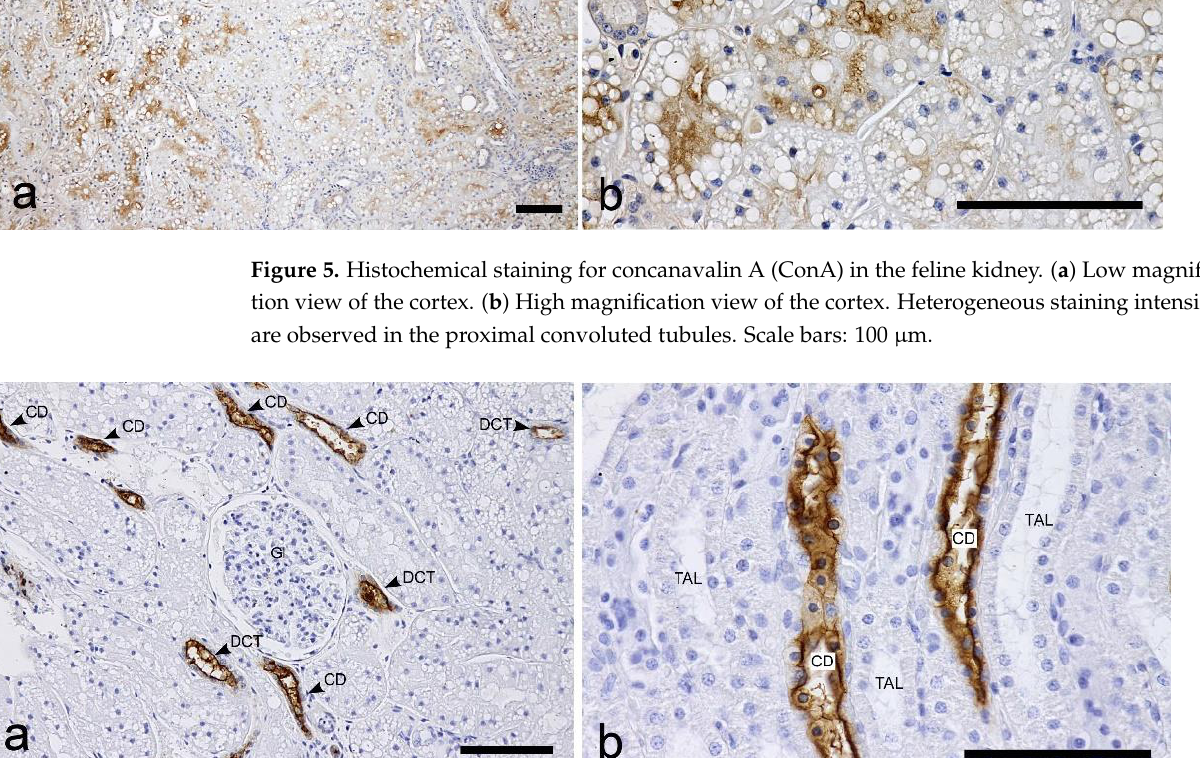
Figure 6. Histochemical staining for Peanut agglutinin (PNA) in the feline kidney. ( a ) Low magnification view of the cortex. ( b ) High magnification view of the inner medulla. Positive labelings are strong in the CDs and DCTs. Scale bars: 100 μm.